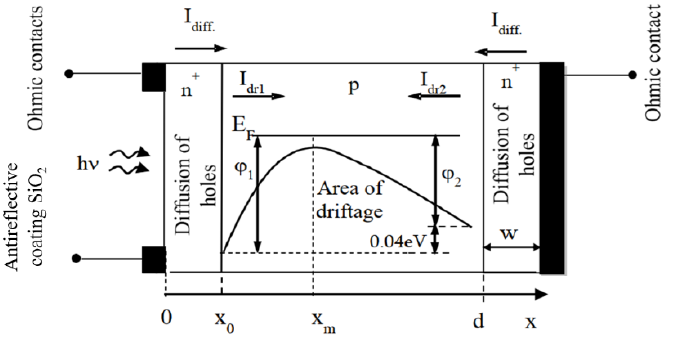
Figure 1. The distribution of the potential energy of holes in the valence band and the direction of the